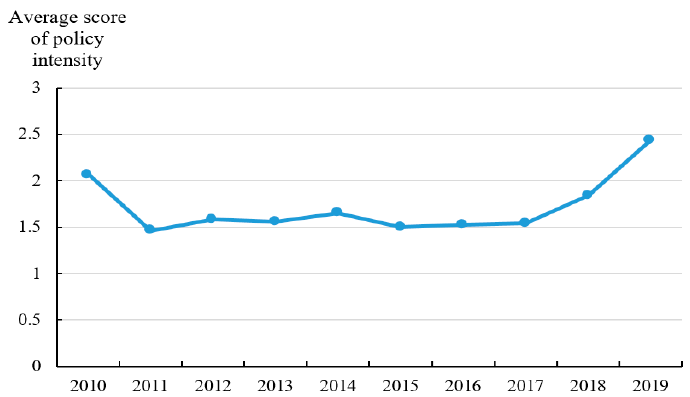
Figure 5. Average score Policy intensity from 2010 to 2019.